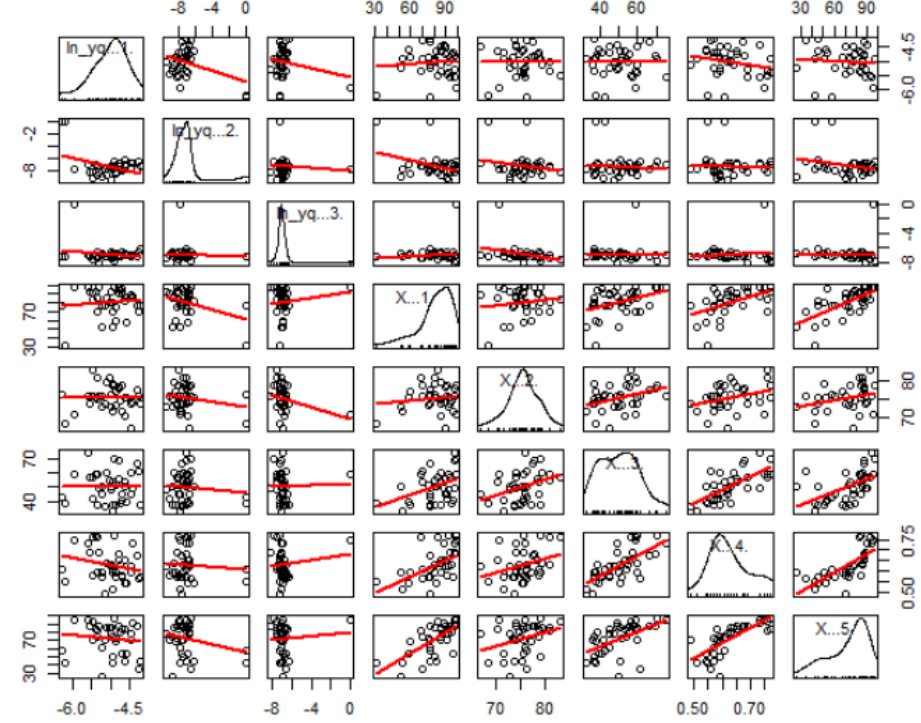
Figure 4. The matrix plot of the response variable and predictor variables.